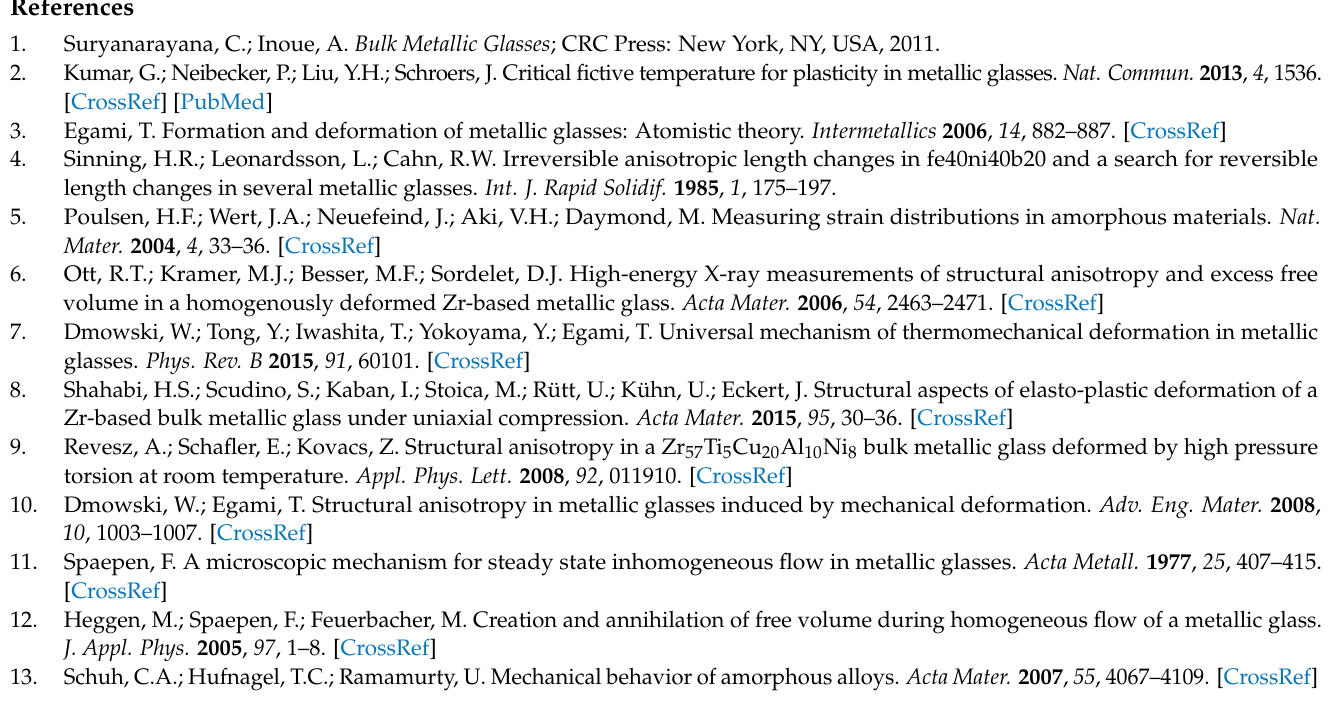
Figure S2: P-h plots at P max = 100 mN along along NR, RW and NW; Figure S3: P-h plots at P max = 50 mN along NR, RW and